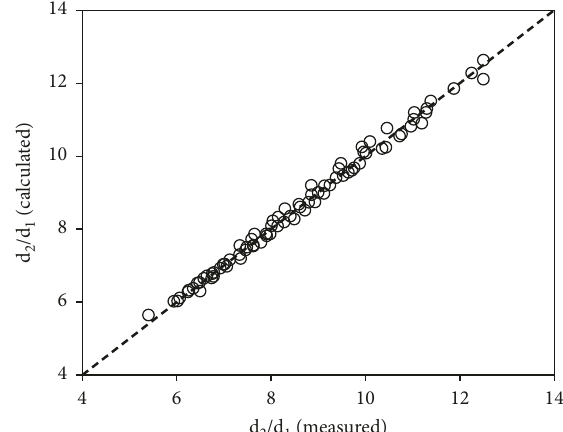
Figure 5: Comparison of the measured and calculated (equation (22)) values of d 2 / d 1